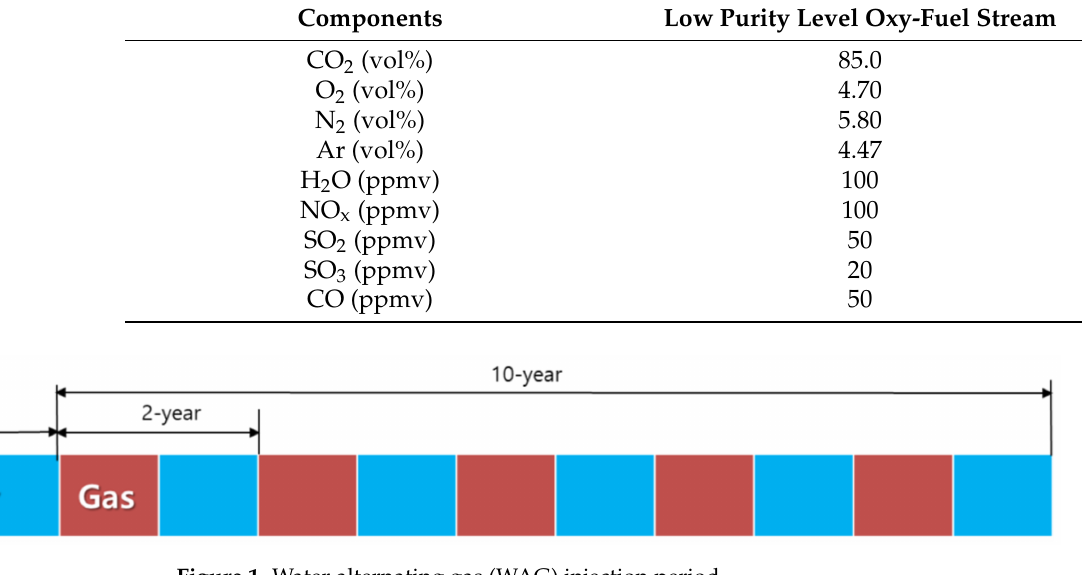
Figure 1. Water alternating gas (WAG) injection period. Table 6. Classification of cases according to impurities